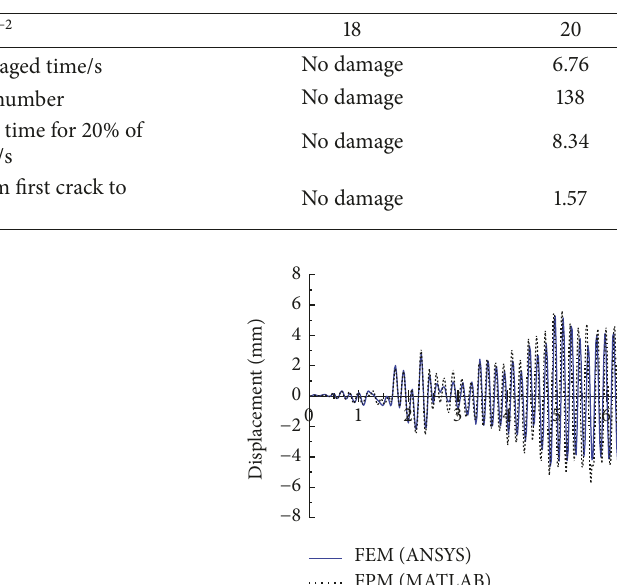
Table 6: Failure time of the transmission tower subjected to different PGAs.